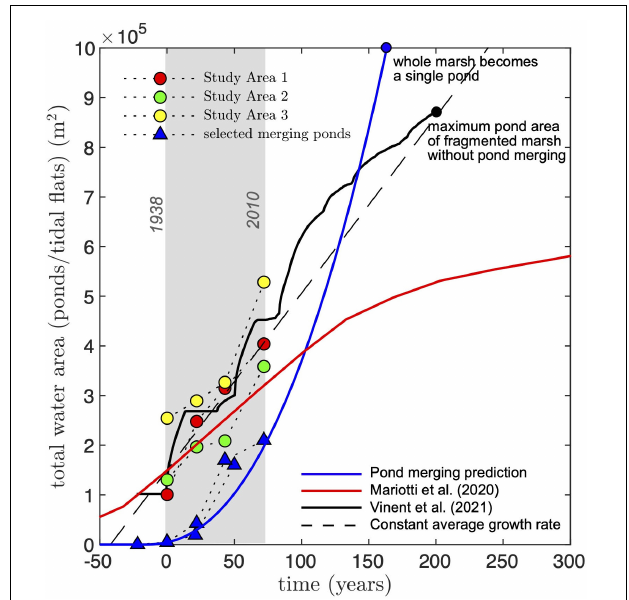
FIGURE 9 | Comparison of measured and predicted time evolution of total water area (ponds). Circles represent total pond area measured in our study areas. Triangles are selected merging ponds tracked through time (we selected the largest merging pond during different merging stages). Merging ponds are shifted in time such that they have a similar size [a ( 0 ) ≈ 5 × 10 3 m 2 ] at the reference time ( t = 0, representing the initial year 1938). All predicted curves are shifted in time such that water area (total pond area) at t = 0 is 1.5 × 10 5 m 2 . The dashed line represents a constant growth rate equal to the average growth rate of all study areas (3.5 × 10 3 m 2 yr − 1 ). The blue line is the prediction for the largest pond area at a given time using the merging rate approximation (Eq. 8). By definition, Eq. 7 represents a lower bound for the total pond area. The black solid line is the prediction using the model of Vinent et al. (2021; Figure 7A ). To compare the model prediction to the measurements, we replaced the size of the central pond in the simulations by the one already present in some of the study areas ( ∼ 10 5 m 2 ) and then rescaled the size of the marsh platform to 10 6 m 2 . The red line is the prediction by the model of Mariotti et al. (2020) for similar marsh conditions (see text for details). To convert from water area fraction to actual water area, we multiplied by the area of their simulated domain (1.44 × 10 6 m 2